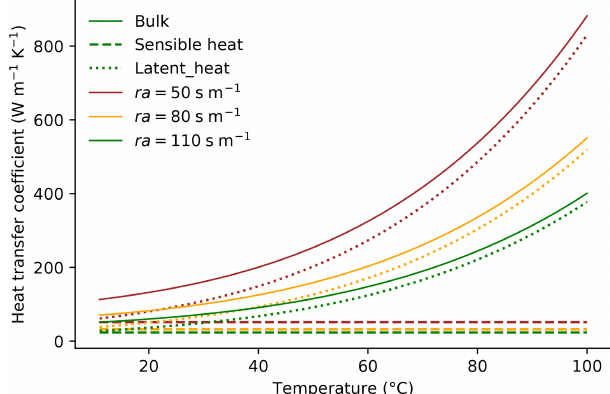
Figure 2. Calculated heat transfer coefficient of the air overlying the land surface and its dependence on the temperature of the land sur- face and aerodynamic resistance ( r a ). The heat transfer coefficient is an artificially high value of thermal conductivity that takes into account the contribution of latent and sensible heat flux to surface heat